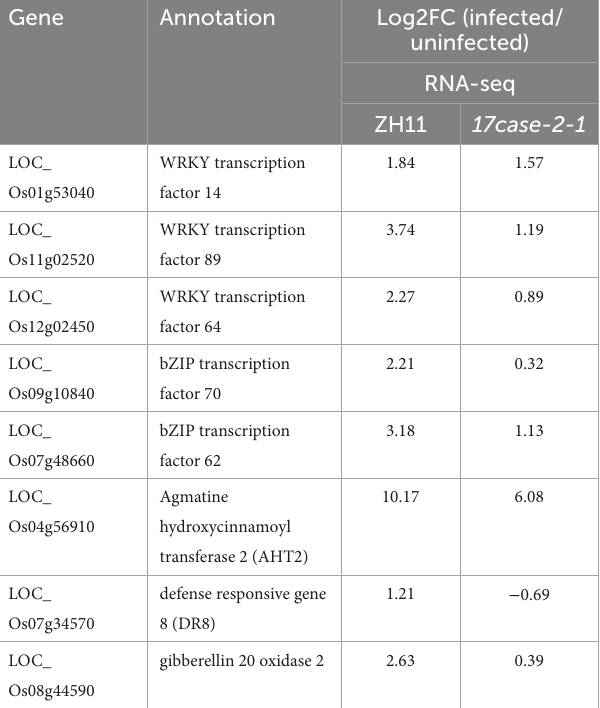
TABLE 1 Partial representative differentially expressed genes. Gene